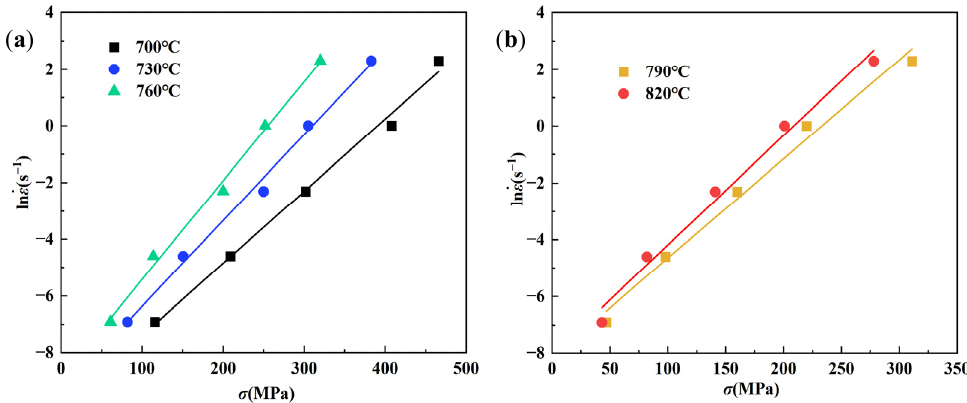
Figure 2. Peak stress adopted to establish constitutive equations.